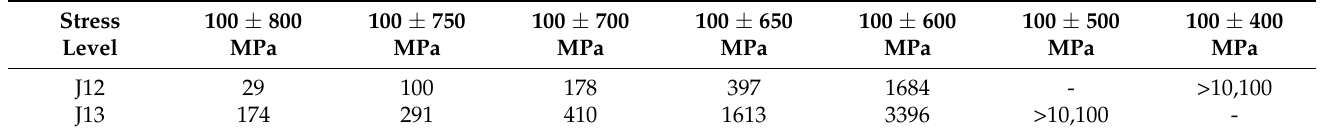
Table 3. Relationship between stress amplitude and cycle order obtained from a ratcheting test for the two different wheel